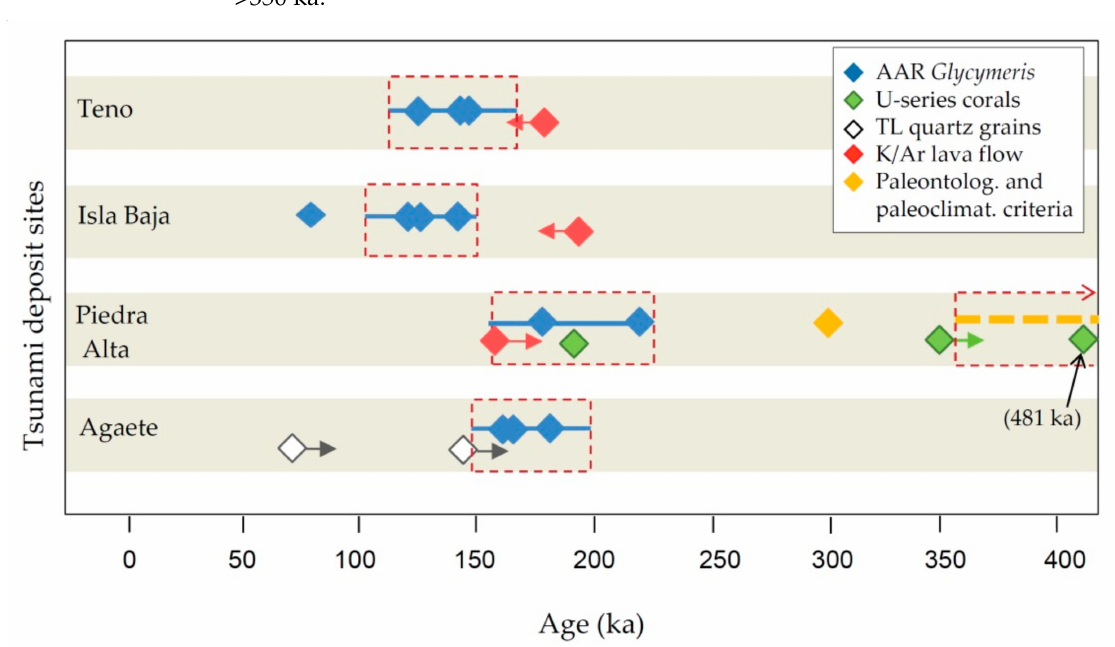
Figure 12. Plot of the age determinations for the tsunami deposits in Tenerife, Lanzarote, and Gran Canaria. K/Ar and paleo-criteria ages from the literature. The dashed red rectangles indicate the most probable ages for the deposits. For Piedra Alta, two alternative age intervals are indicated, although we favor the younger age. Table 1. Age determinations of the tsunami deposits in the Canary Islands.